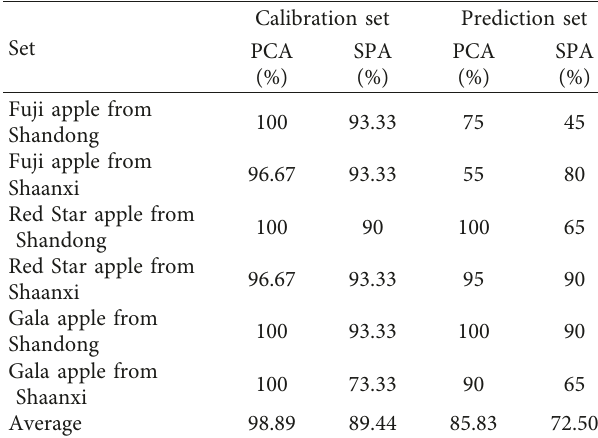
Table 6: Classification accuracies of SVM models.